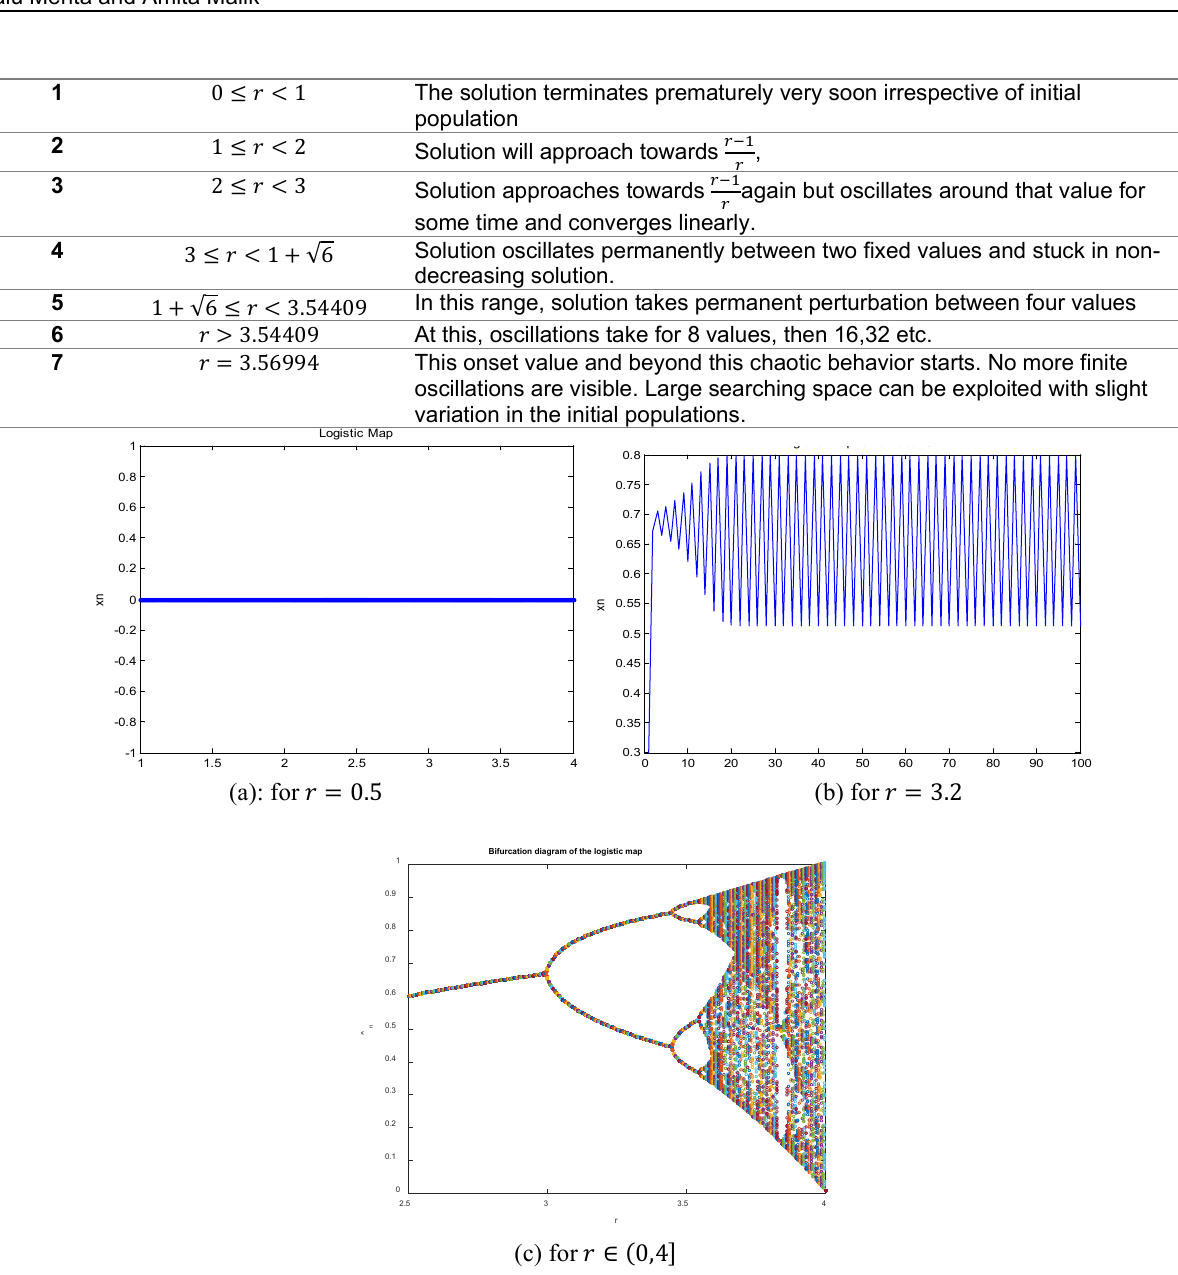
𝑒𝑒 ∈ (0,4] Figure 3. Stationary, periodic and bifurcation behavior of logistic